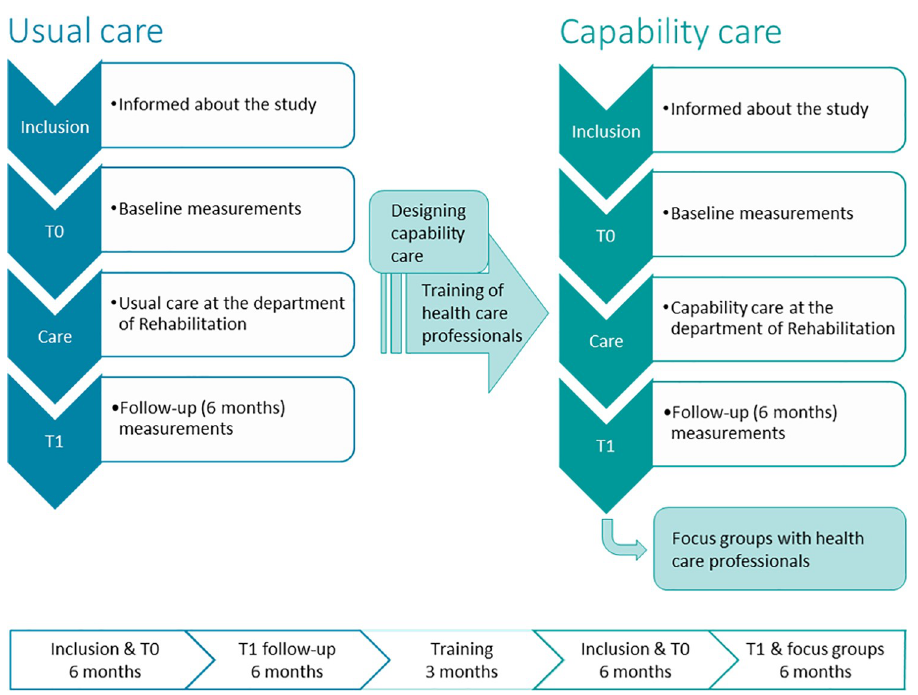
Fig 3. Flowchart of the ReCap-NMD study. Patients are included and baseline measurements take place before their first appointments at the department of Rehabilitation of the of the Radboudumc Center of Expertise for neuromuscular disorders. Follow-up measurements will take place after 6 months. In total, a period of one year per group is planned for inclusion and follow-up. In between usual care and capability care, a period of 3 months is planned to train the healthcare professionals in providing capability